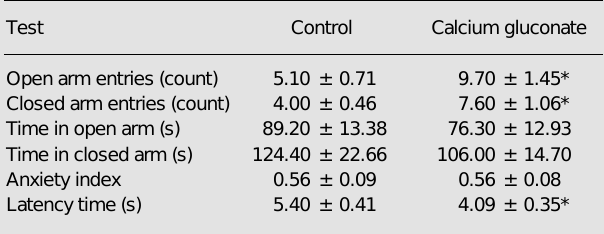
Table 3. Elevated plus-maze behavior of rats receiving distilled water containing 1% calcium gluconate for 3 days.